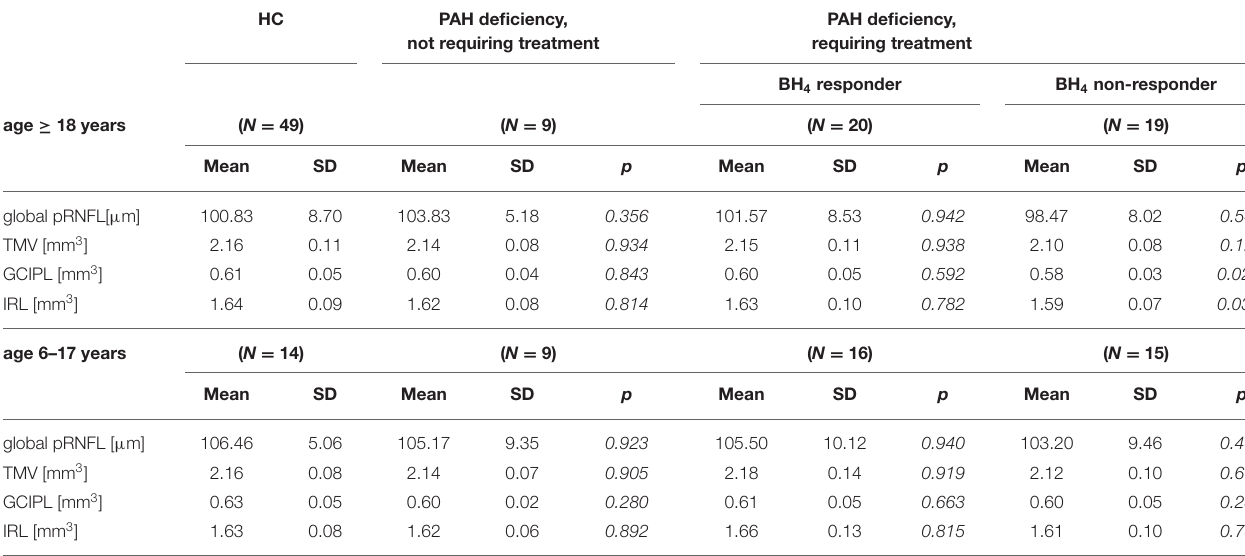
TABLE 3 | OCT findings related to phenotype of PAH deficient patients diagnosed within the neonatal period by newborn screening. HC PAH deficiency, not requiring treatment